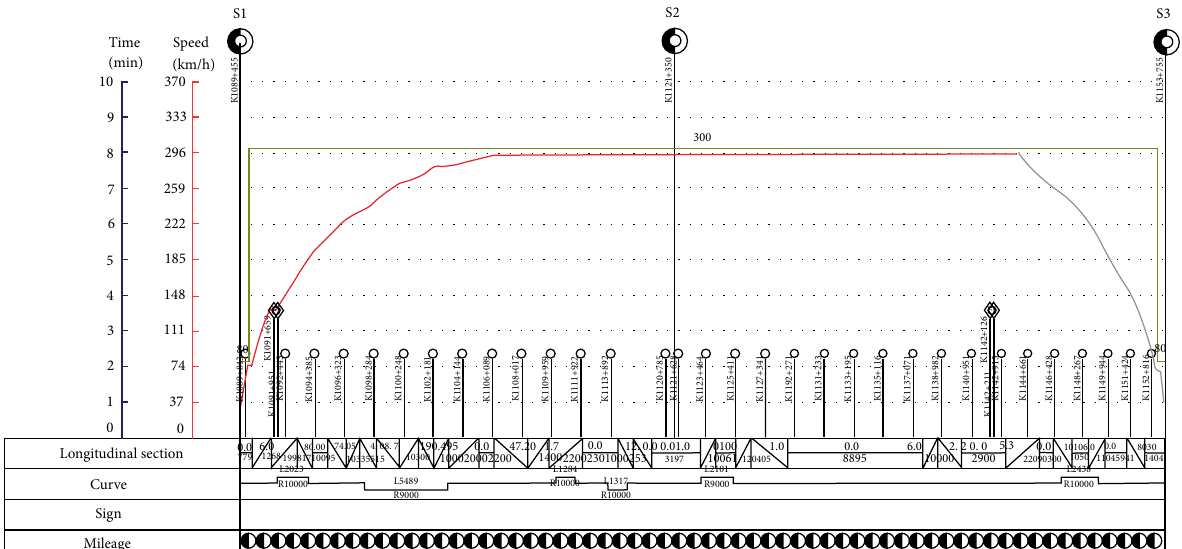
Figure 1: The running state of train 𝐽